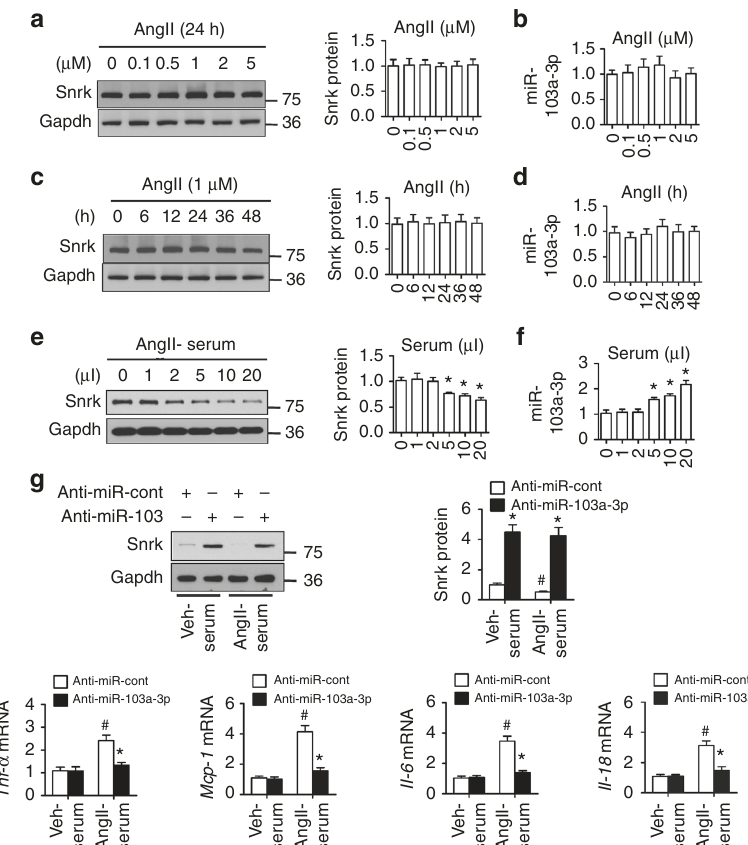
Fig. 6 AngII-infused mouse serum reduces Snrk expression in cultured GnECs. a Western blot and densitometry analysis of Snrk levels in primary GnECs isolated from wild-type (WT) mice following treatment with different doses of AngII. b Quanti fi cation of miR-103a-3p levels by qRT-PCR in primary GnECs treated with different doses of AngII. c Western blot and densitometry analysis of Snrk levels in GnECs isolated from WT mice following different incubation times with 1 µ M AngII. d Quanti fi cation of miR-103a-3p levels by qRT-PCR in primary GnECs treated with AngII for different durations. e – h Serum collected from WT mice infused with a vehicle control (Veh) or AngII (1 mg kg − 1 d − 1 ) for 4 weeks was used to treat GnECs. Snrk proteins levels ( e ) and miR-103a-3p abundance ( f ) were determined for GnECs treated for 8 h with different doses of AngII-treated mouse serum. n = 6; * p < 0.05 relative to untreated controls. GnECs pretreated with AAV-anti-miR-103a-3p or AAV-anti-miR-Control for 24 h and subsequently incubated with vehicle control- or AngII-treated mouse serum (10 µ l) were subjected to the analysis of Snrk protein levels ( g ) and cytokine mRNA levels ( h ). n = 6 per group; * p < 0.05 relative to anti-miR-Control/AngII; # p < 0.05 relative to vehicle-treated mouse serum. Student ’ s two-tailed t -test was used for the statistical analysis. The corresponding source data are available in the Source Data fi